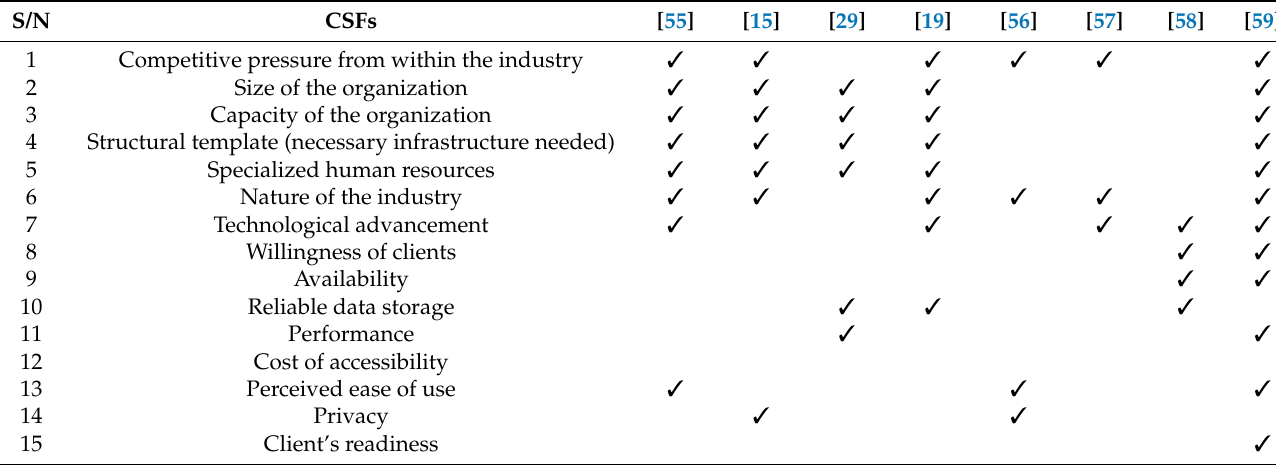
Table 1. Cloud computing